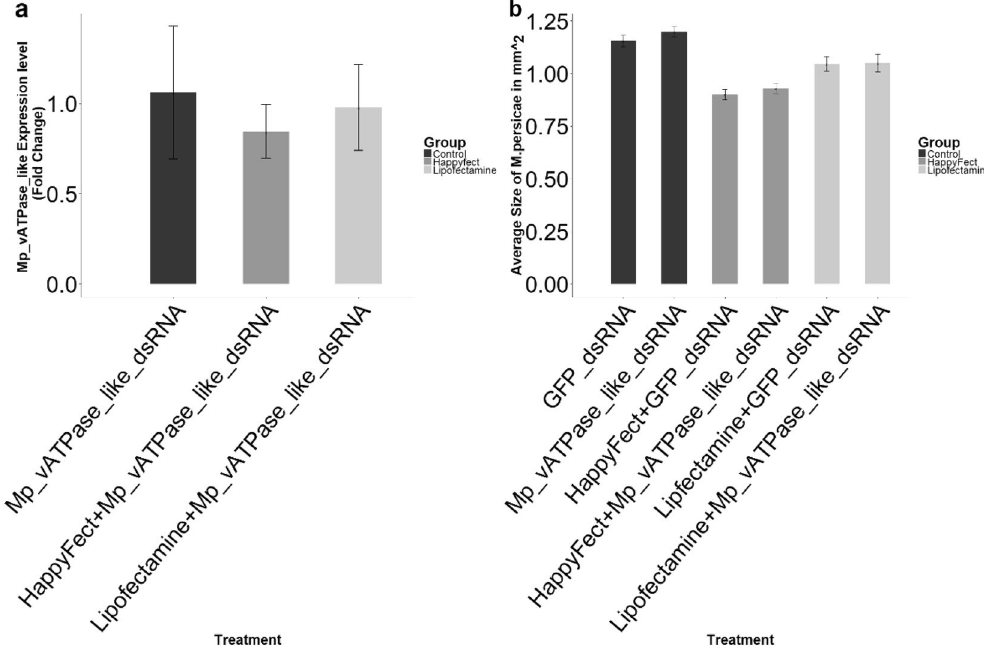
Figure 2. Mp_vATPase-like_dsRNA fed to M . persicae in artificial diet does not affect size or cause a knockdown of the target, even when delivered with transfection agents. ( a ) Quantitative real-time PCR showing that MP_vATPase-like transcripts level are not significantly different whether the aphids are fed Mp_vATPase- like_dsRNA or GFP_dsRNA . The fold change is not significantly different regardless of the transfection reagent used (ANOVA, p = 0.96, reps = 3). Total number of insects present in each replicate GFP_dsRNA - 4, 10, 8, Mp_vATPase – 4, 7, 8. ( b ) Aphid size does not differ between those fed on a diet containing Mp_vATPase-like_ dsRNA and those fed GFP_dsRNA (Student t-test, p = 0.24), although use of the transfection agent does affect aphid size (Happyfect: p = 0.38, Lipofectamine: p = 0.94). The error bars show the standard error of the mean based on replicates = 3 replicates of 10